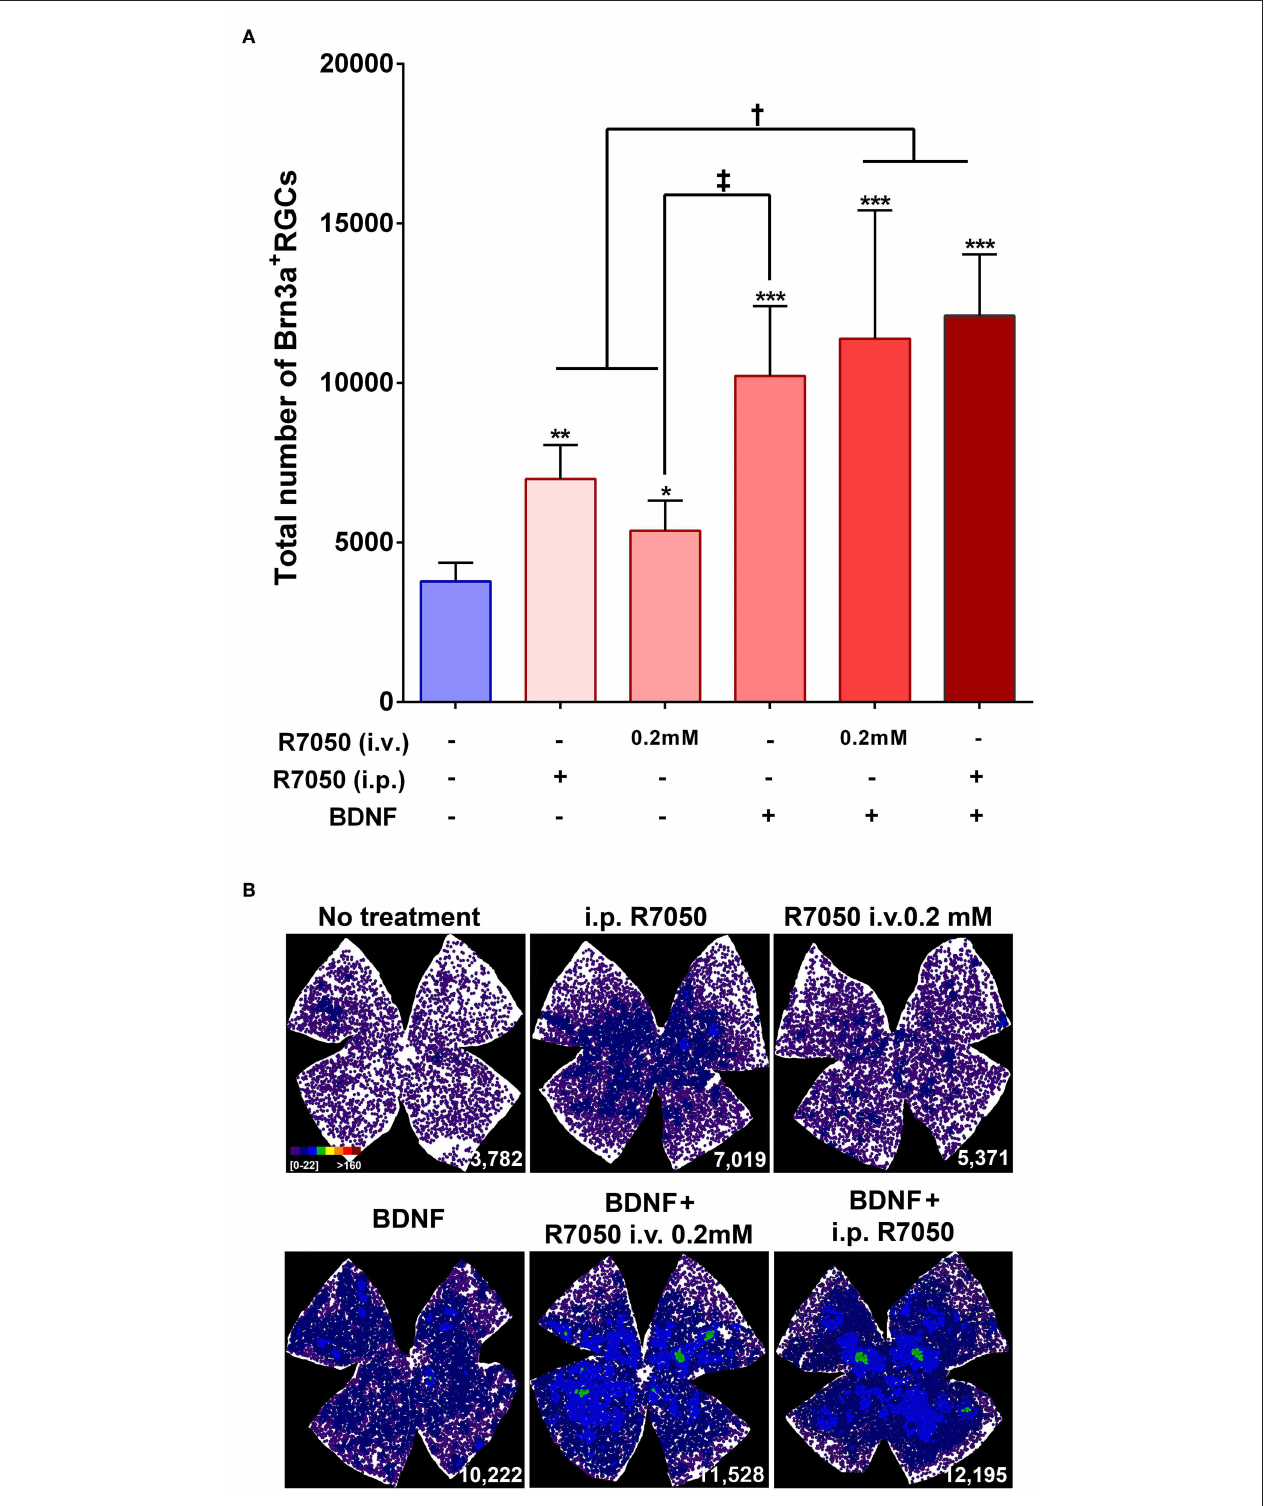
FIGURE 4 | Systemic and intravitreal treatment with R7050 alone or in combination with BDNF rescues RGCs during the slow phase of death after optic nerve axotomy. (A) Column bar graph showing the total mean number ± standard deviation of RGCs quantified in the different animal groups analyzed 14 days after